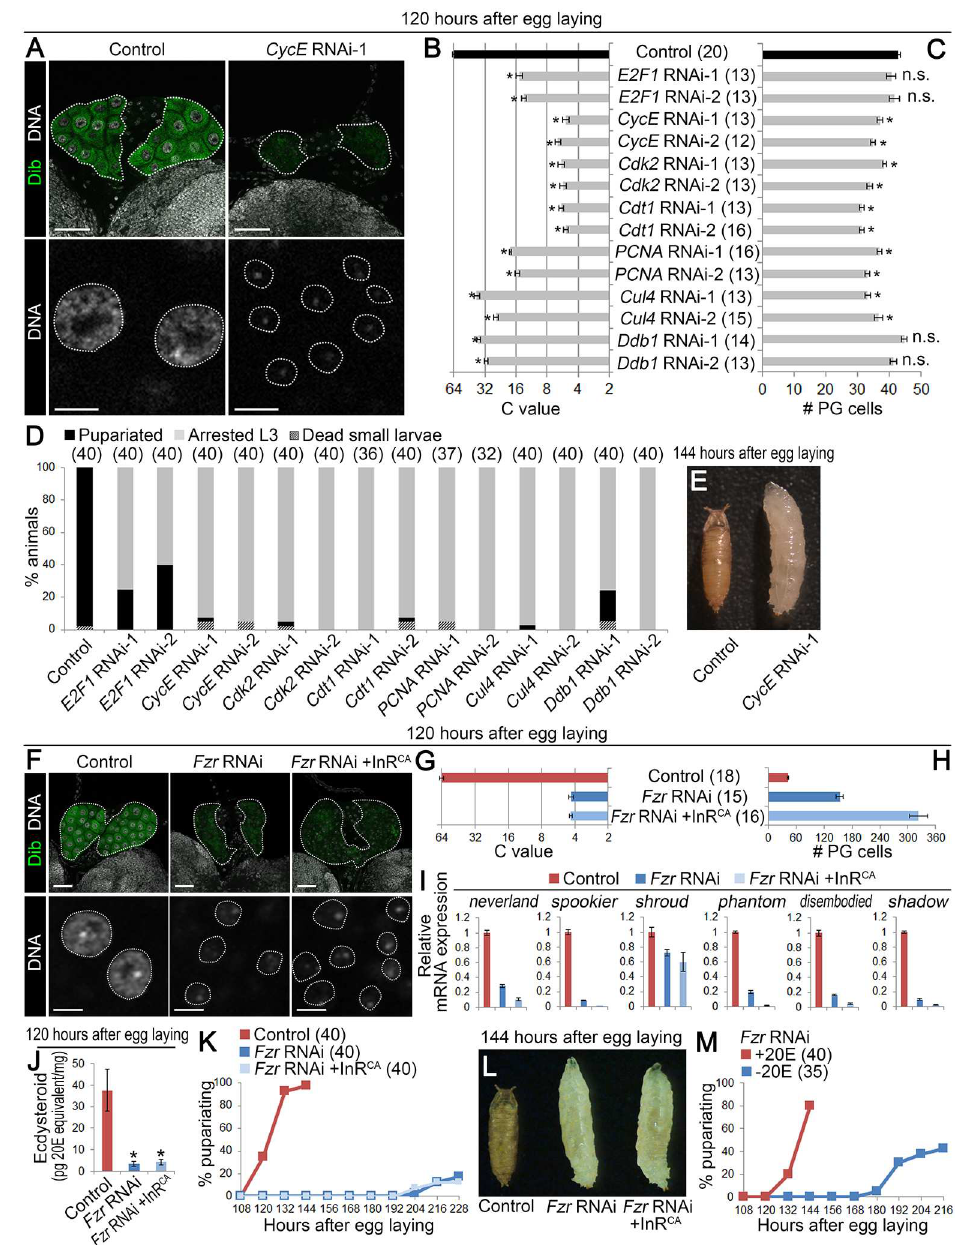
Fig 3. Endocycle is required for ecdysone biosynthesis. (A) Knockdown of CycE in the PG causes reduction in DNA content. The PGs (upper panels, outlined) and nucleiof PG cells (lowerpanels, outlined)of control ( phm22 > dicer2 )and CycE RNAi-1 ( phm22 > dicer2 , CycE RNAi-1 ) animalswere labeled for Dib (green)and DNA (white) at 120 hAEL. Scale bars, 50 μ m (upper panels) and 10 μ m (lower panels). (B and C) Knockdown of endocycleregulatorsin the PG causes reduction in DNA content. Each gene was knocked down using two independentRNAi lines. The C value (B) and number (C) of PG cells of control (black bars) and RNAi ( phm22 > dicer2 , RNAi ; gray bars) larvae at 120 hAEL. Average C value in control is normalized to 64C. Error bars represent standard errors. Numbers of animalstested are in parentheses. Significance was calculatedusing Student’s t -test ( * P < 0.001; n.s., Not significant). (D) Knockdown of endocycleregulatorsin the PG causes arrest at the 3rd instar larval stage. Developmental profiles of control and RNAi animals are shown. Numbers of animalstested are in parentheses. (E) Pupariatedcontrol animal(left) and CycE RNAi-1 larva arrested at the 3rd instar stage (right). (F) Knockdown of Fzr in the PG causes block of mitotic-to- endocycle transition. The PGs (upper panels,outlined)and nuclei of PG cells (lower